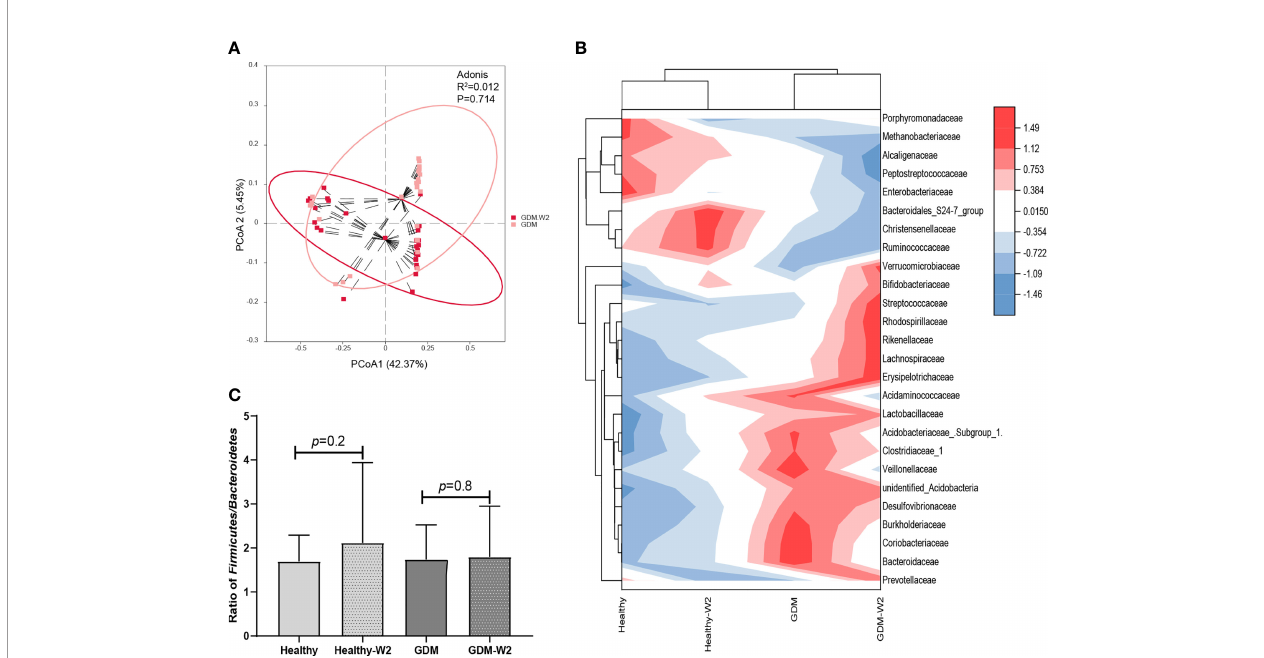
FIGURE 4 | The microbial pattern after diet management. (A) Principal coordinate analysis (PCoA) at the OTU level between the GDM-W2 and healthy-W2 groups. (B) Heatmap analysis of the differential taxa at the family level. (C) Ratio of Firmicutes/Bacteroidetes among the GAM and non-GDM groups with or without diet